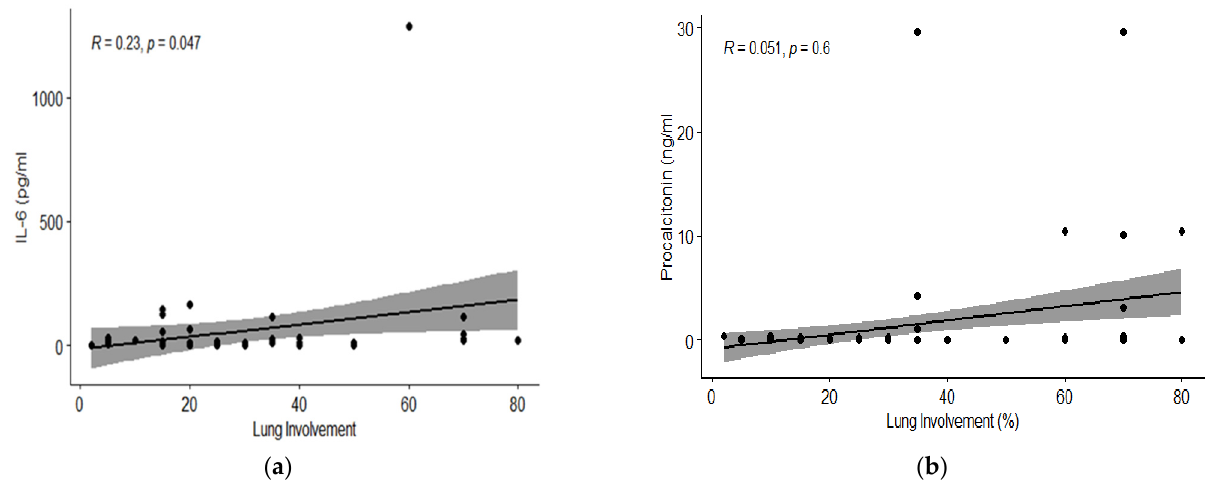
Figure 2. Correlation of chest CT lung involvement with different inflammatory biomarkers: ( a ) interleukin ‐ 6 (pg/mL); ( b ) Procalcitonin (ng/mL). On the x ‐ axis the lung damage in percent (con ‐ tinuous scale) is represented and on the y ‐ axis the value of IL ‐ 6 and procalcitonin respectively. The median values of CRP, NLR, IL ‐ 6, and procalcitonin were: 67.7, 5.70, 8.66, re ‐ spectively, 0.06 for the group with lung involvement below 50%, and 129.2, 12.8, 46.49, respectively, 0.31, for the group with lung involvement above 50% (Figures 3 and 4). CRP, NLR, IL ‐ 6, and procalcitonin values were statistically significantly higher in pa ‐ tients with lung involvement above 50% compared to patients with lung involvement below 50% ( p = 0.001, p = 0.006, p < 0.001, and p = 0.001, respectively).